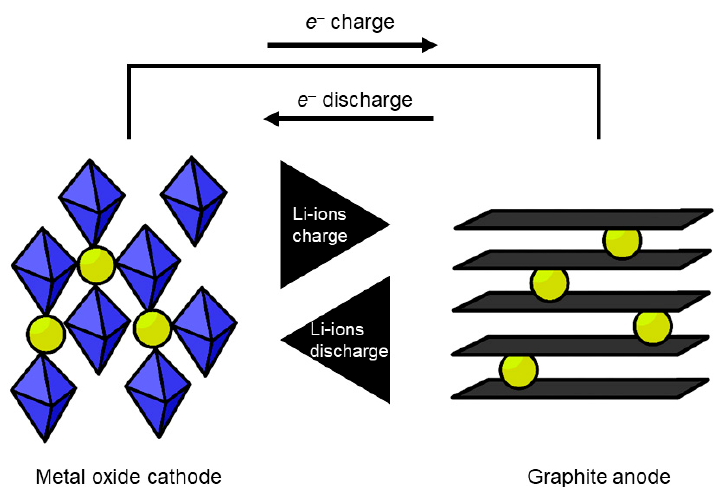
Figure 2. The ion flow in lithium-ion battery: When the cell charges and discharges, ions shuttle between cathode (positive electrode) and anode (negative electrode). On discharge, the anode undergoes oxidation, or loss of electrons, and the cathode sees a reduction, or a gain of electrons. During charge, the movements are reversed.